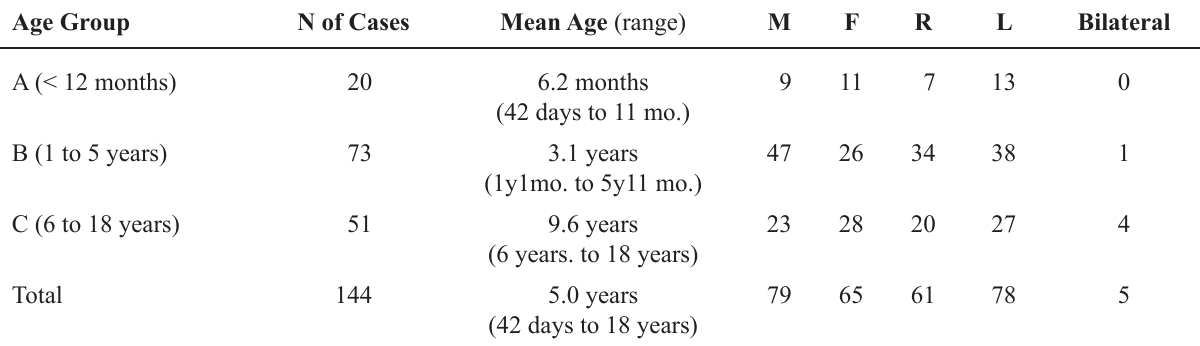
M = male; F = female; R = right; L = left; p > 0.05 for gender and side distribution among the 3 age